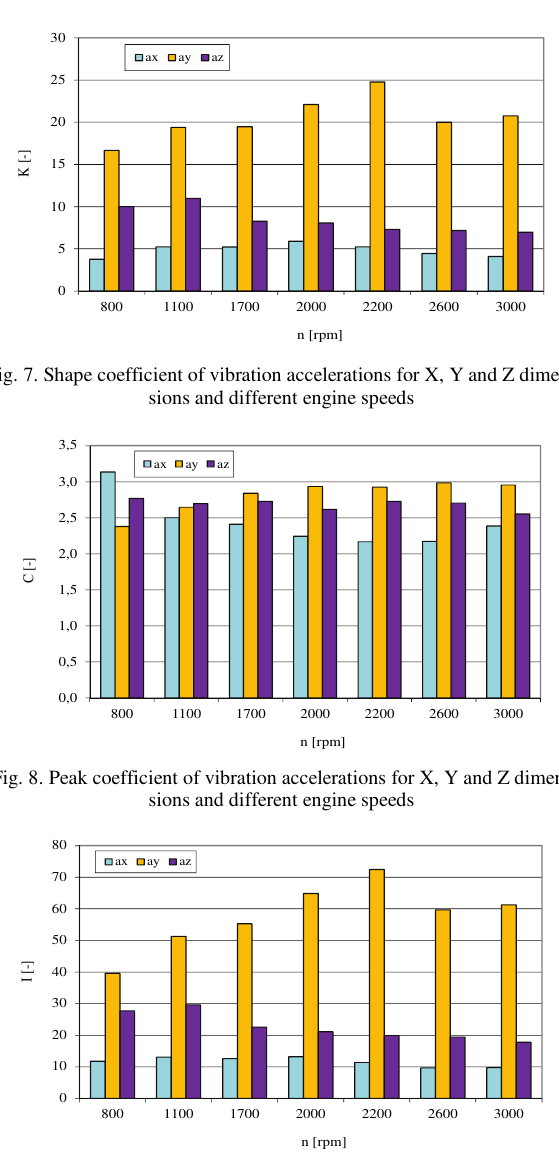
Fig. 9. Impulse coefficient of vibration accelerations for X, Y and Z di- mensions and different engine speeds